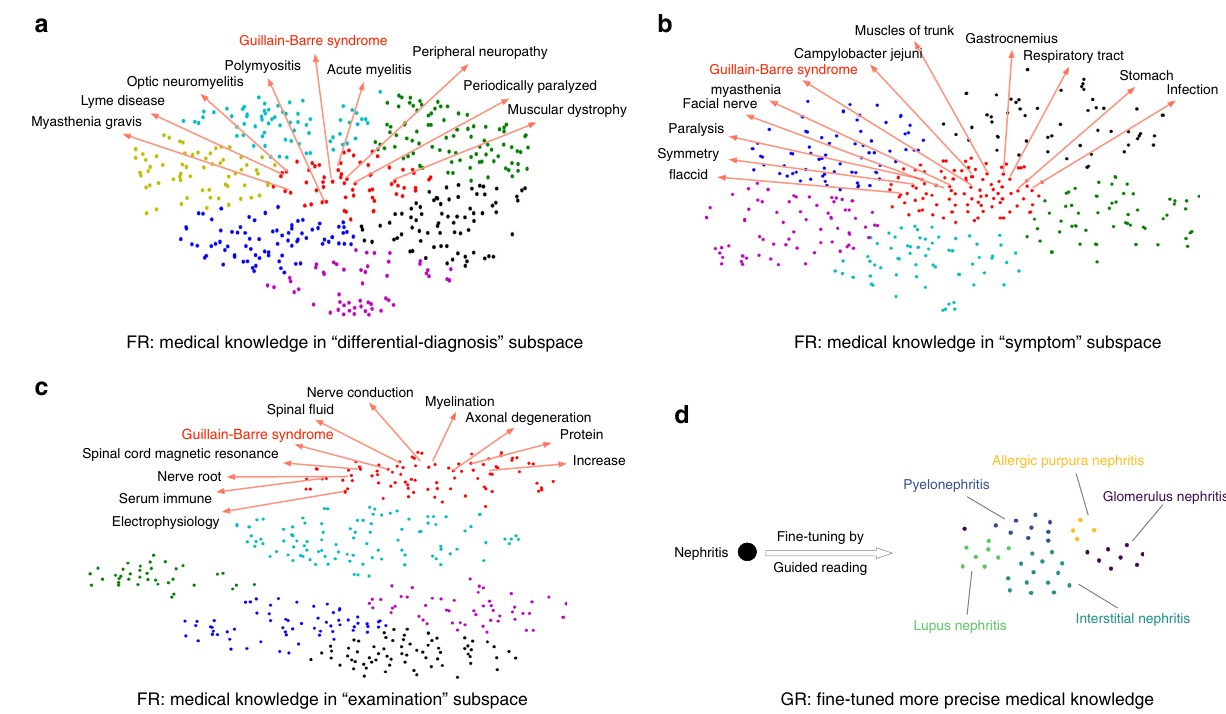
Fig. 6 Example of medical knowledge obtained with “ Free Reading ” and “ Guided Reading ” . We use implicit embeddings to represent and capture medical knowledge from a large medical corpus. In the FR phase, we produce a series of embeddings to depict different kinds of medical knowledge. Take disease “ Guillain-Barre syndrome ” for example, in a “ differential-diagnosis ” embedding subspace similar diseases are close to each other, while in b “ symptom ” embedding subspace medical terms describing symptom of Guillain-Barre syndrome are clustering, and while in c “ examination ” embedding subspace medical terms related to examination to “ Guillain-Barre syndrome ” are clustering. In the GR phase, medical terms ’ embeddings obtained from FR are fi ne- tuned by supervised learning models to get more rich and precise medical knowledge based on their context. For example, in d the embedding of “ nephritis ” is fi ne-tuned into different variants to describe and represent subtle different meanings in different